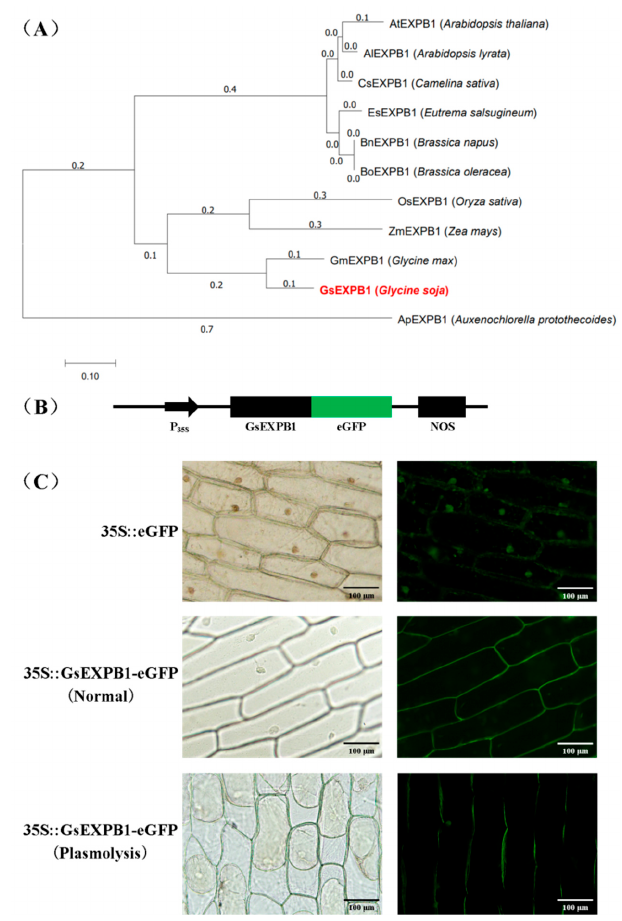
Figure 9. Amino acid phylogenetic tree of GsEXPB1 and results of its subcellular localization in onion epidermal cells. ( A ) Amino acid phylogenetic tree of GsEXPB1 and EXPB1s in other 10 plant species, values indicate evolutionary branch length (genetic variability). ( B ) GsEXPB1 expression vector construction for onion epidermal cells subcellular localization test. P 35S indicates CaMV35S promoter, eGFP indicates enhanced green fluorescent protein, NOS indicates terminator. ( C ) GsEXPB1 subcellular localization results, bar = 100 μ m.